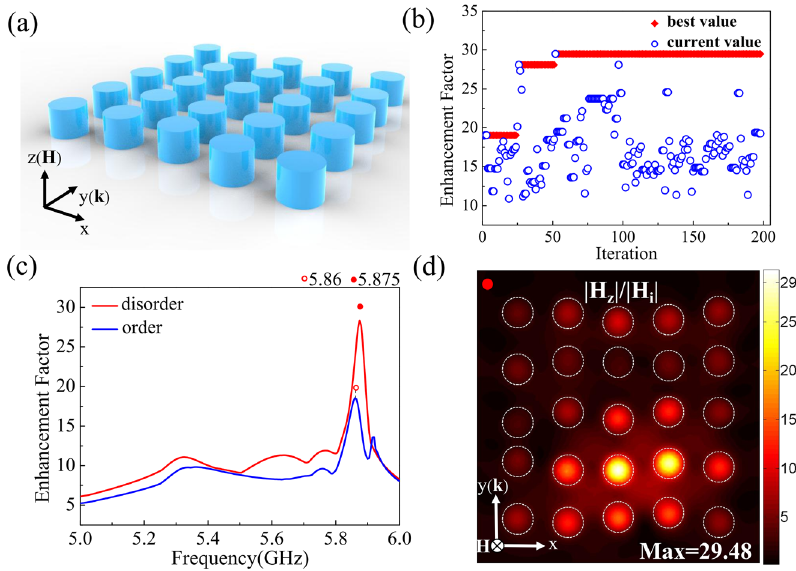
seen from Figure 3(c). The corresponding result (blue line) of the optimized ordered structure ( D x = 22.76 mm and D y = 25.62 mm) is shown for comparison. The maximized enhancement factors of the disordered structure also outperform the ordered one in a broad band manner. It should be pointed out that the achievable maximum magnetic fi eld enhancement and the realization of ho- structure is a trade-off. These numerical results indicate Figure 3: (a) The schematic of the all- dielectric disordered resonators. The po- larizationoftheplanewaveismarkedinthe inset. The radius and height of all resona- tors are the same as Figure 2. The lattice constants of the ordered 5 × 5 array are D x = 22.76 mm and D y = 25.62 mm, respectively. (b) The largest enhancement factor of magnetic fi eld | H z | (best value) and the temporary one (current value) obtained on the plane 1 mm above the structure during the iteration of optimization. (c) The spectra of the largest enhancement factor of magnetic fi eld | H z | calculated for the disordered and ordered structures, respectively. The largest magnetic fi eld enhancement is at 5.92 GHz for ordered structure and 5.935 GHz for disordered structure.(d) The normalized magnetic fi eld | H | distributions at the optimized results z (5.935 GHz) of the disordered structure on a plane 1 mm above the surface of the